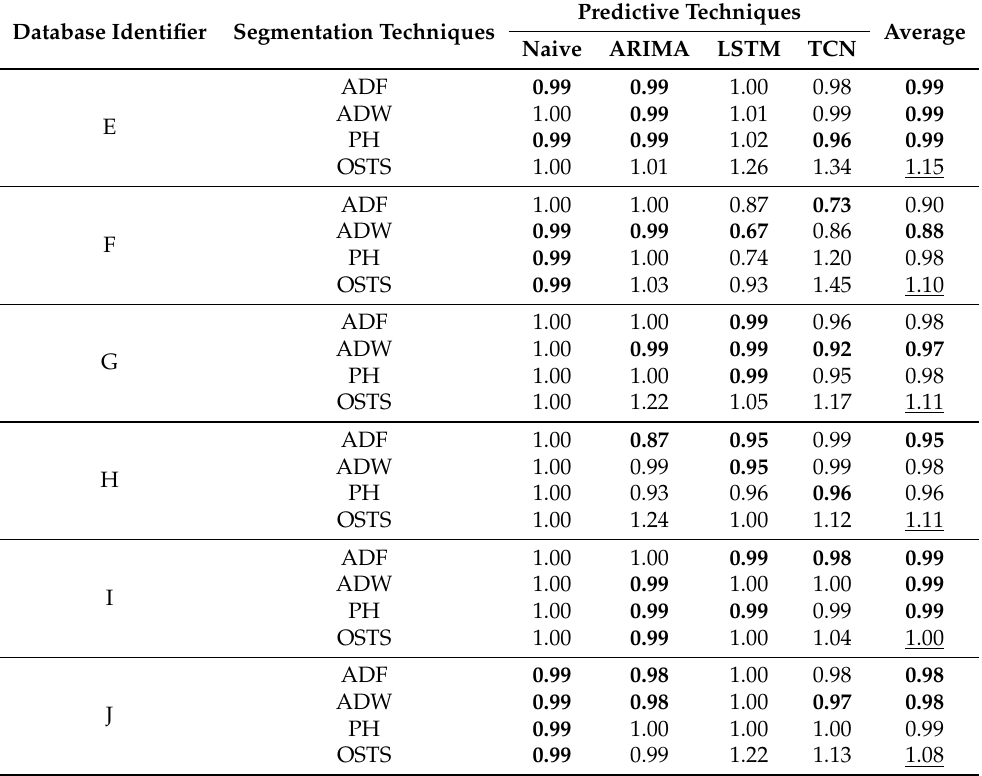
Table 5. Cont. Database